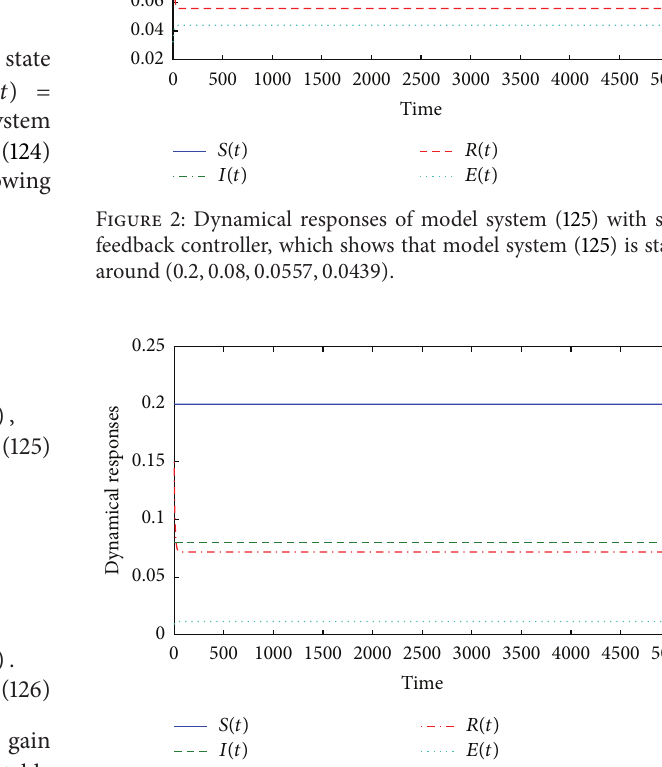
Figure 3: Dynamical responses of model system (126) with state feedback controller, which shows that model system (126) is stable around (0.2,0.08, 0.07175, 0.0115) . Table 3: Values of parameters for numerical